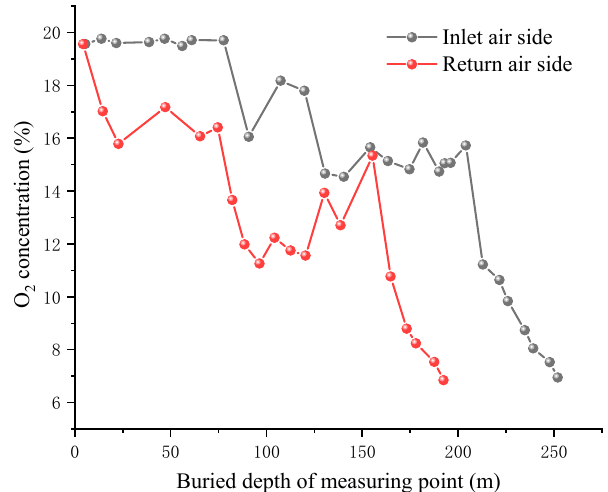
Figure 3. Distribution of O 2 concentration at measuring points on the return air and the inlet air side.